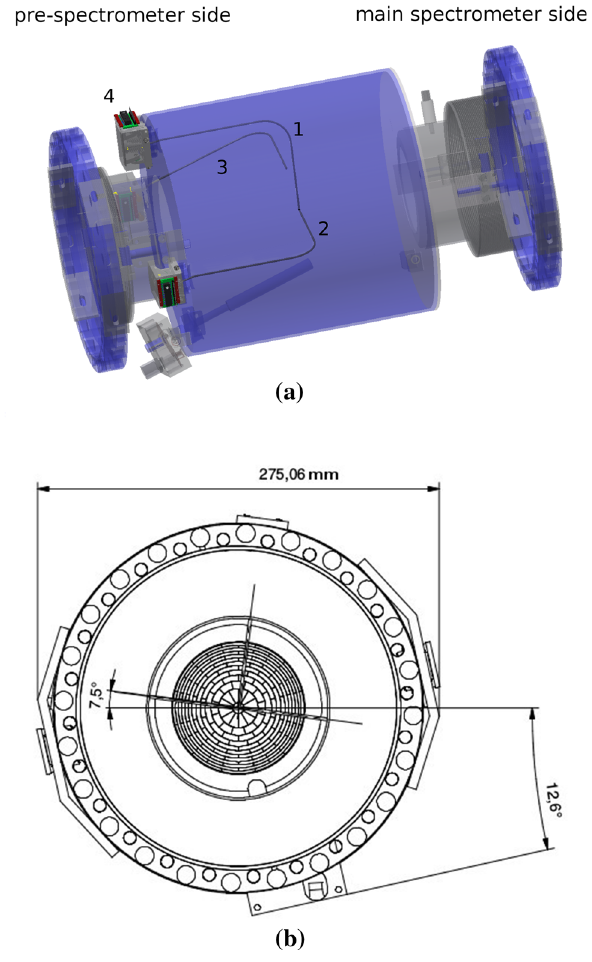
Fig. 4 a The beamline region inside the superconducting solenoid betweenthepre-andmainspectrometers.(1),(2),(3)theelectroncatch- ers;(4)acatcher’scontroller; b endviewoftheelectroncatchersintheir operational positions, relative to the FPD looking down the beamline toward the main